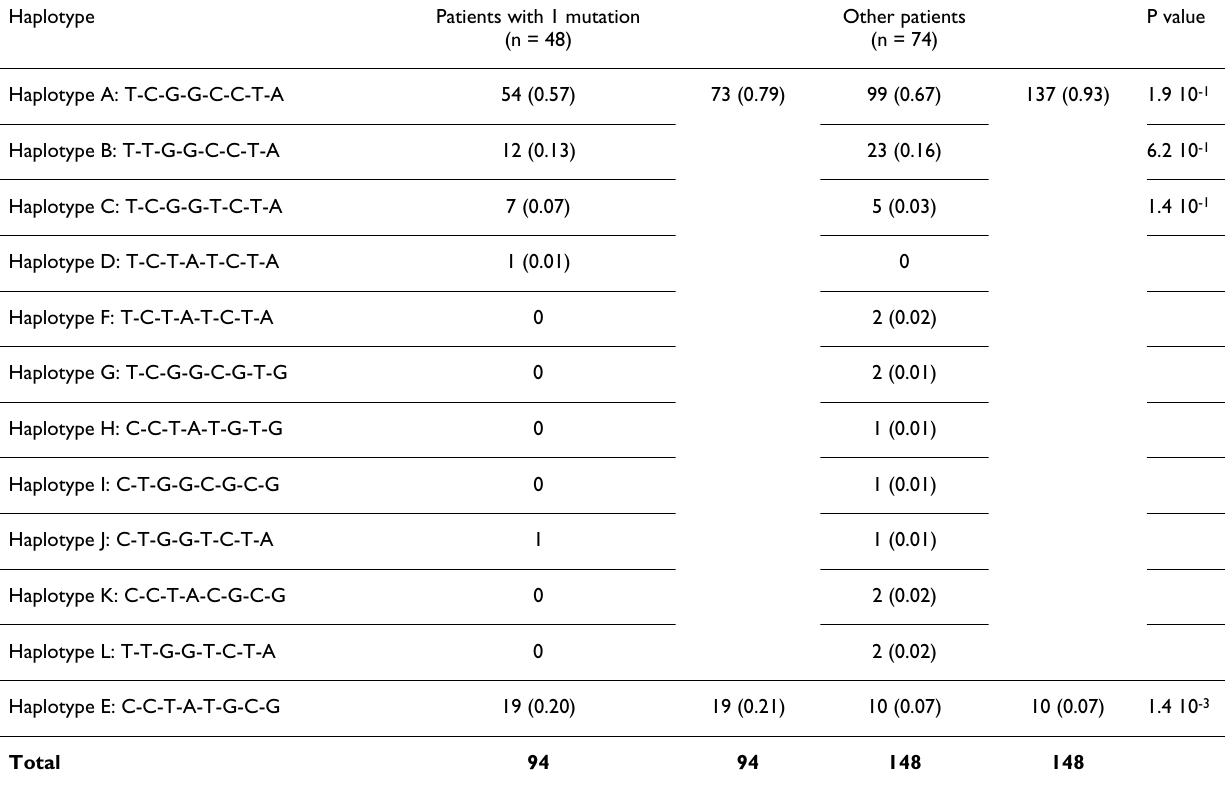
Table 4: Distribution of SNPs haplotypes in the patients carrying only one heterozygous mutation and in patients with two characterized mutated alleles. Haplotype Patients with 1 mutation (n =